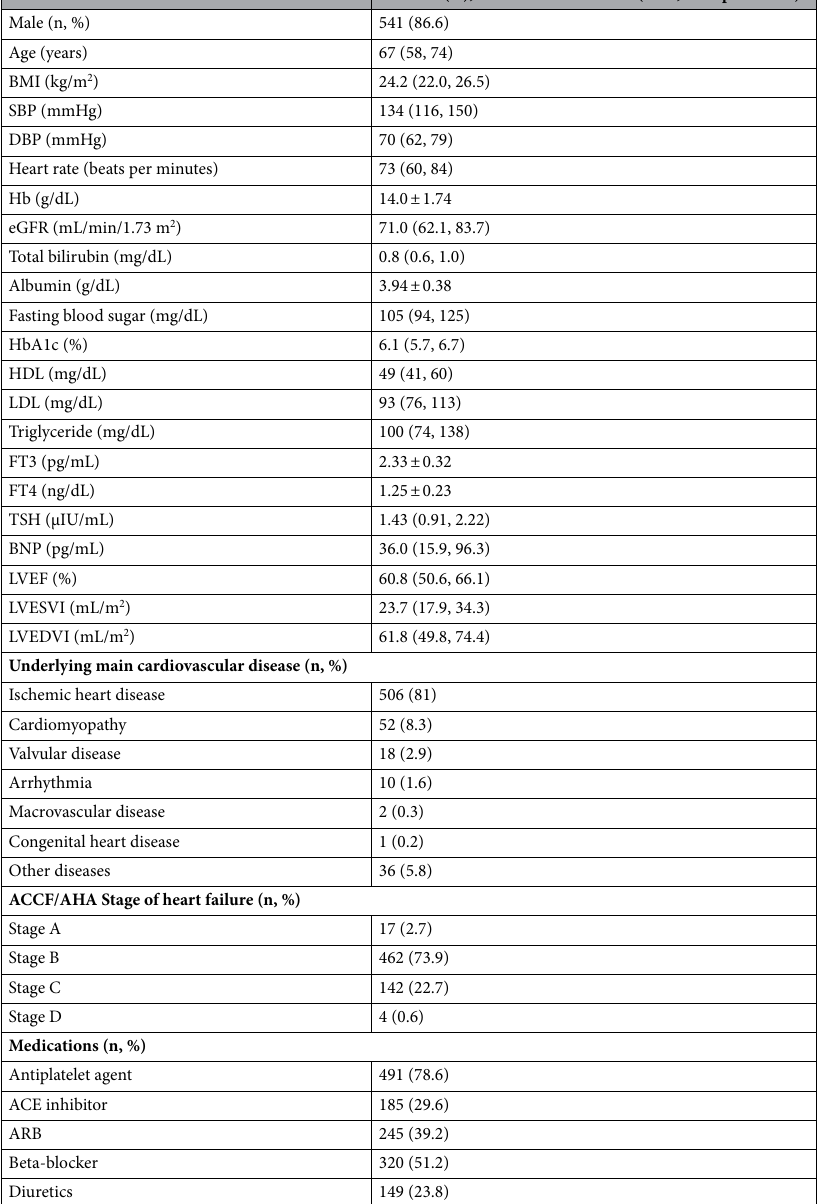
Table 1. The clinical characteristics of the patients (n = 625). SD, standard deviation; BMI, body mass index; SBP, systolic blood pressure; DBP, diastolic blood pressure; Hb, hemoglobin; eGFR, estimated glomerular filtration rate; HDL, high-density lipoprotein cholesterol; LDL, low-density lipoprotein cholesterol; FT3, free triiodothyronine; FT4, free thyroxine; TSH, thyroid-stimulating hormone; BNP, B-type natriuretic peptide; LVEF, left ventricular ejection fraction; LVESVI, left ventricular end-systolic volume index; LVEDVI, left ventricular end-diastolic volume index; ACCF, American College of Cardiology Foundation; AHA, American Heart Association; ACE, angiotensin-converting enzyme; ARB, Angiotensin II Receptor